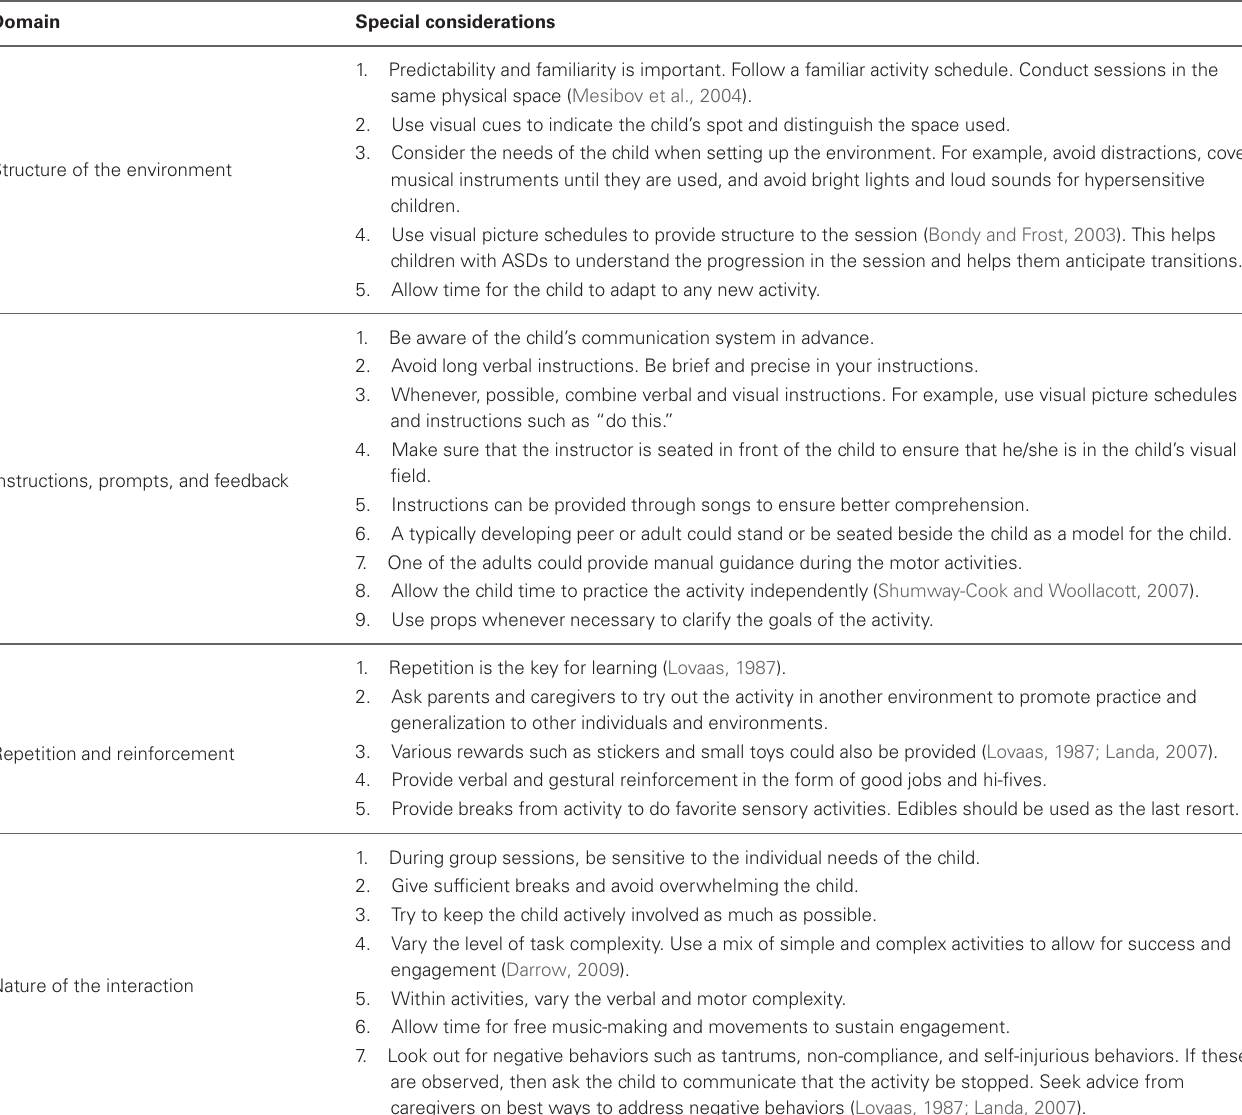
Table 3 | Special considerations for music-based interventions for children with ASDs.